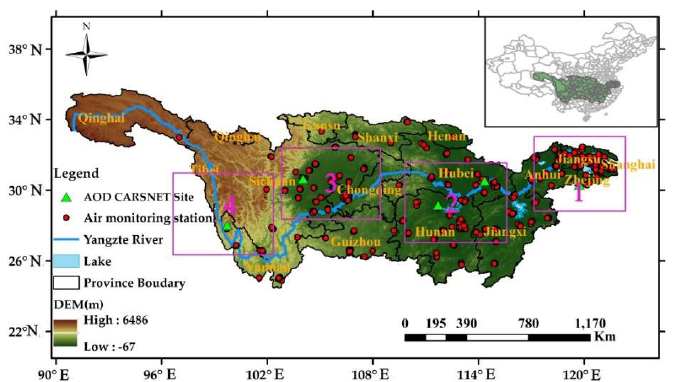
Figure 1. Distribution of ground air monitoring stations and China Aerosol Remote Sensing Network (CARSNET) sites over the Yangtze River Basin (YRB). The YRB was divided into four regions, labeled from 1 to 4, which are the Yangtze River Delta (YRD), Central China (CC), Sichuan Basin (SB) and source of the YRB